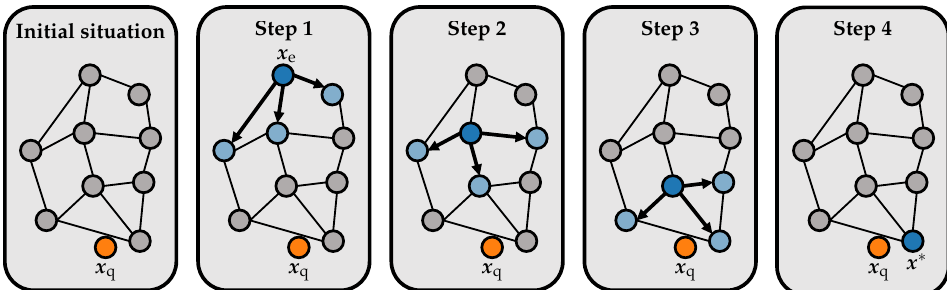
Figure 3. Illustration of graph-based approximate nearest neighbor